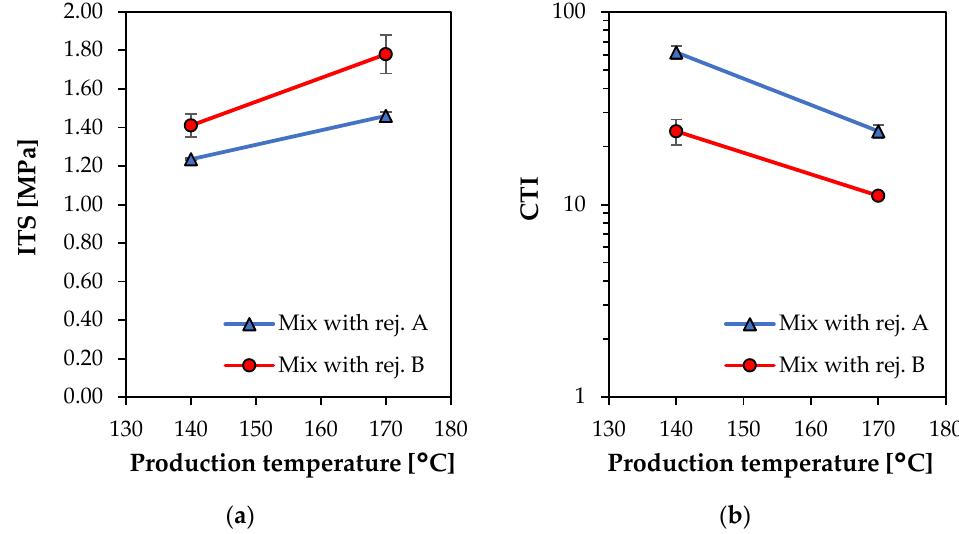
Figure 5. Variation of ITS ( a ) and CTI ( b ) as a function of mix production temperature and rejuvenator type.